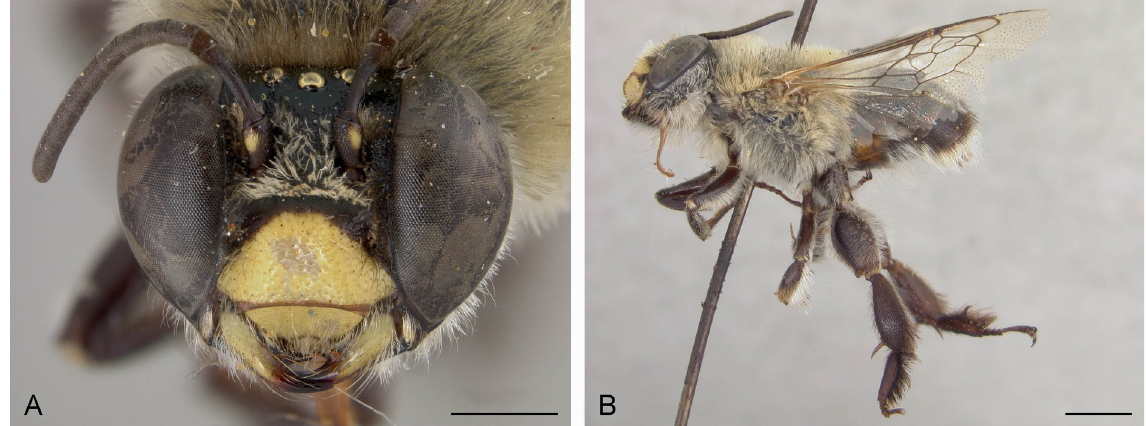
Fig. 16. Centris petreae Cockerell, 1949, holotype, ♂ (NMNH; USNM ENT 00534210). A . Frontal view. B . Habitus, lateral view. Scale bars: A = 1 mm; B = 2